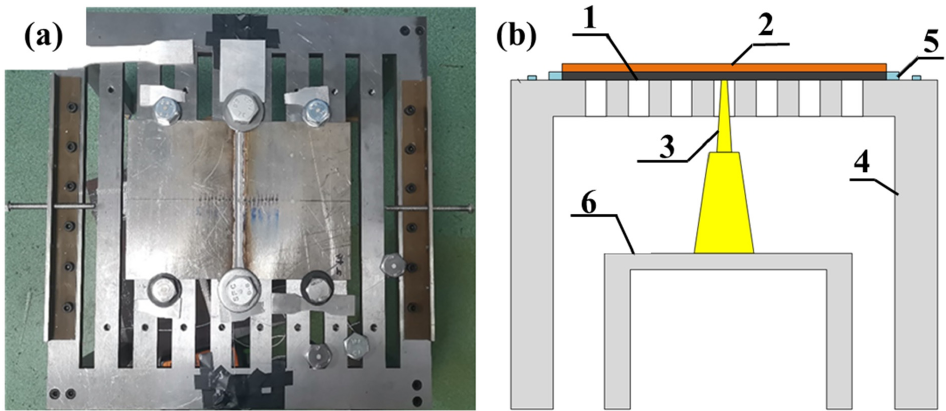
Figure 1. Self-made residual stress control system: ( a ) Physical drawing of fixture (top view); ( b ) Fixture diagram (front view).